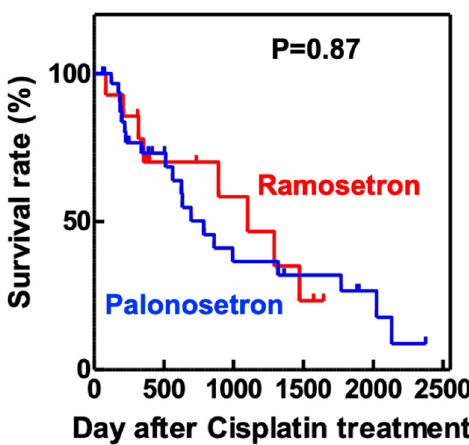
Figure 4. Kaplan–Meier overall survival analysis of patients treated with cisplatin and either ramosetron or palonosetron. Patients with head and neck cancer ( n = 103) received cisplatin and 5-fluorouracil, together with either ramosetron ( n = 26) or palonosetron ( n = 77), to treat chemotherapy-induced nausea and vomiting. p value determined using the log-rank test.